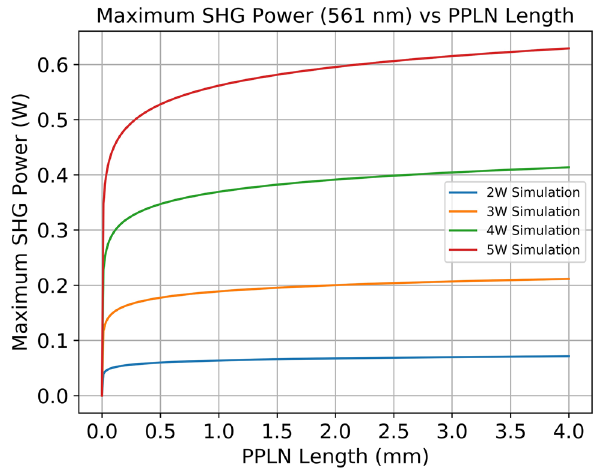
Figure 4. Simulated maximum SHG Power at 561 nm vs. PPLN length for several values of 808 nm pump